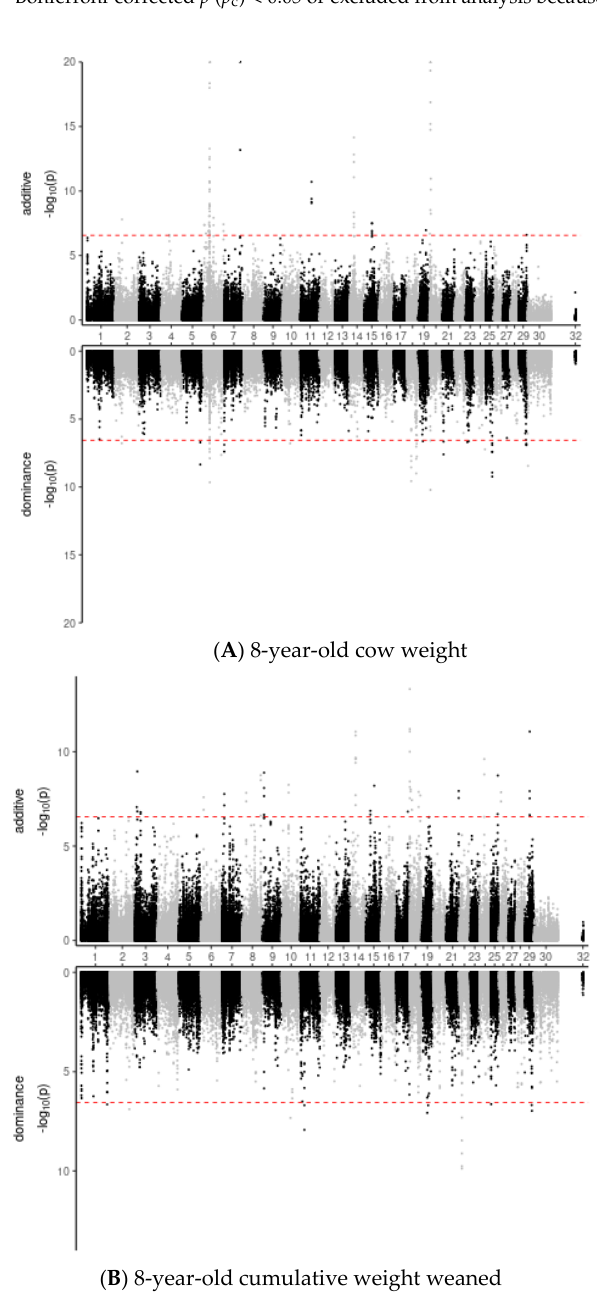
Figure 3. Miami plots depicting significance of variants affecting projected 8-year-old cow weight ( A ) and cumulative weight weaned ( B ). Additive effects are above the axis, dominance effects are below. Chromosomes are autosomes 1 to 29, X (30), and the pseudoautosomal region of X (32).